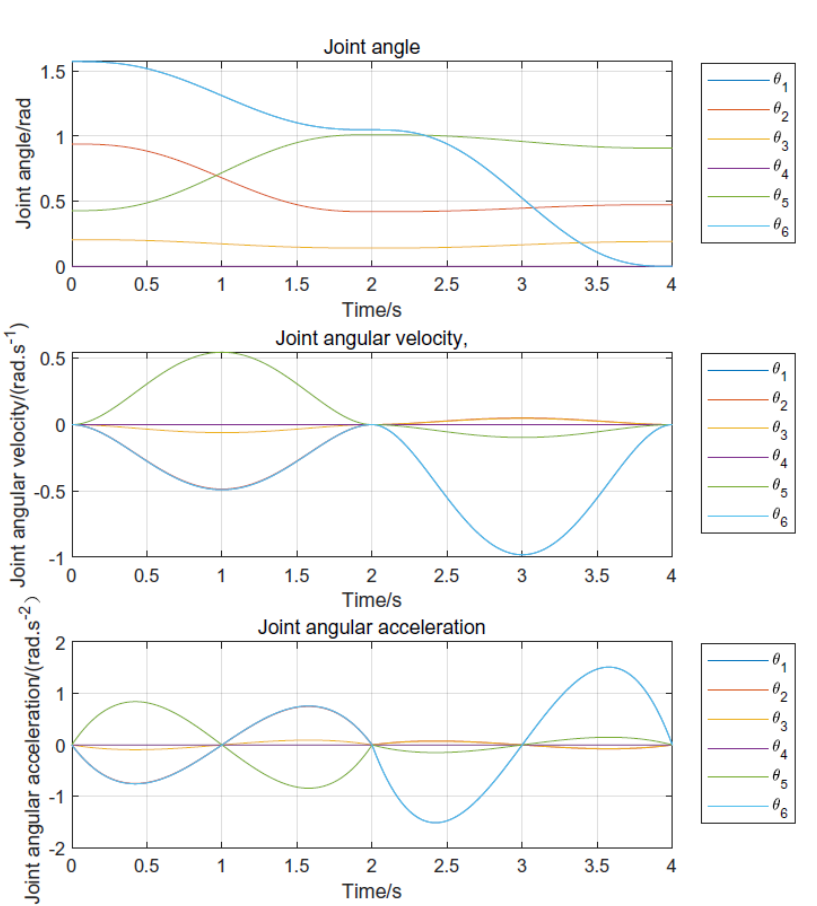
Figure 7. The displacement, velocity and acceleration curve of each joint.